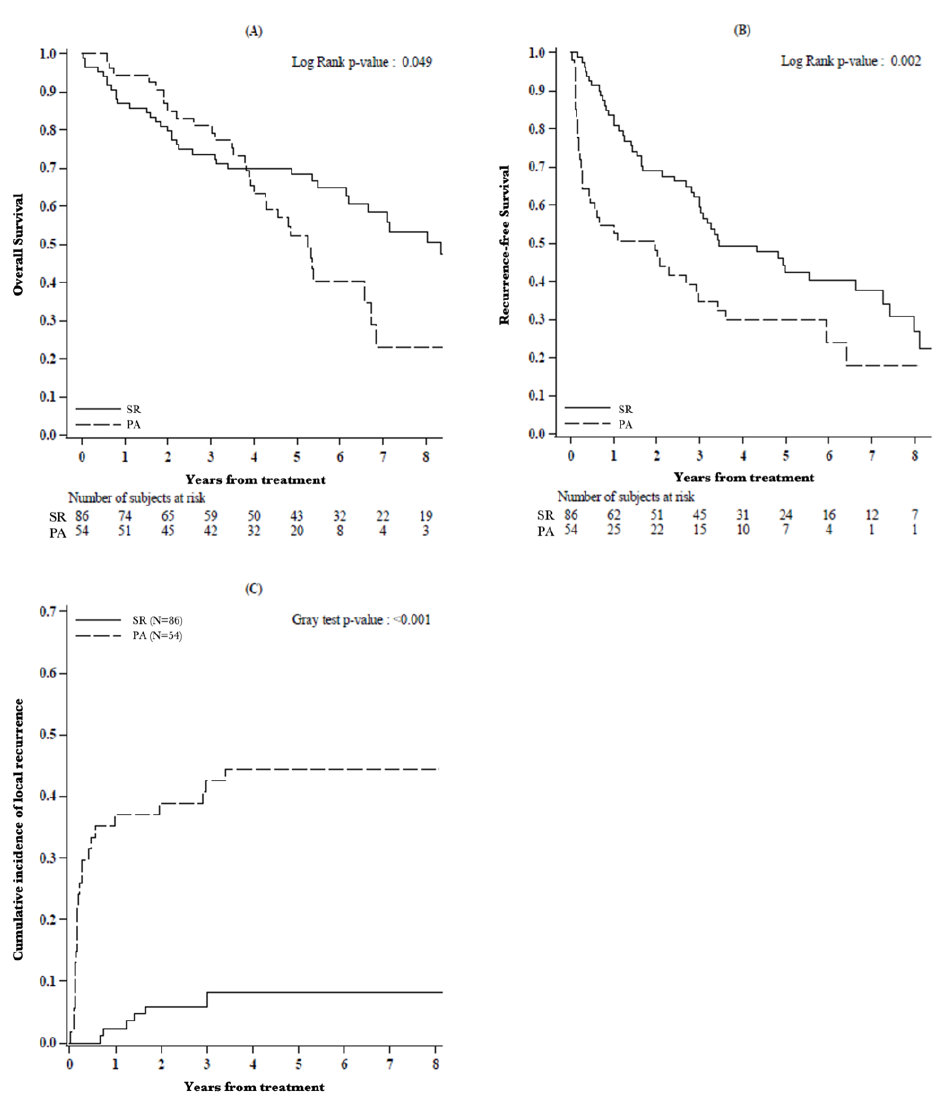
Figure 2. ( A ) Overall survival, ( B ) recurrence-free survival and ( C ) cumulative incidence of local recurrence by type of treatment (N = 140).